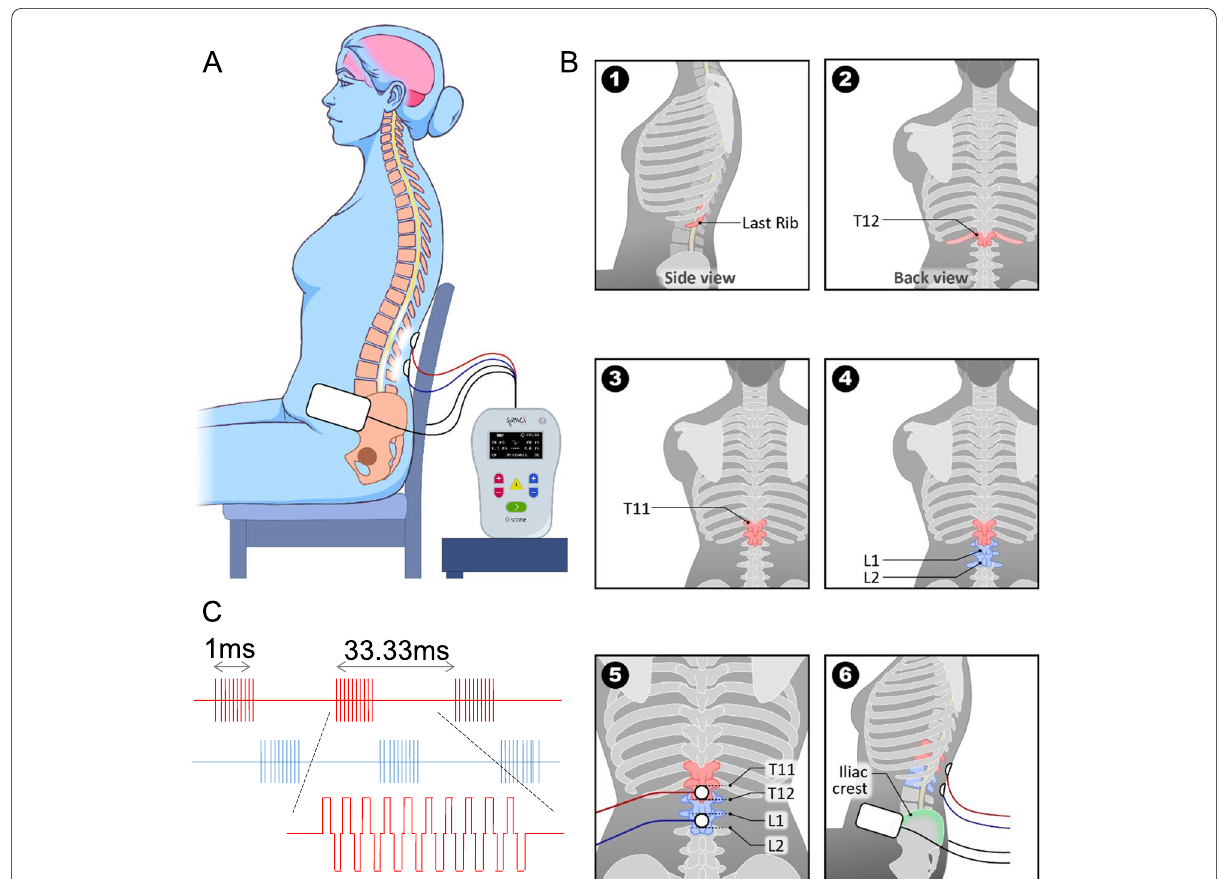
Fig. 1 A Schematic representation of experimental setup. B Step by step representation of position the anode and cathode and C Electrical waveforms used in the current